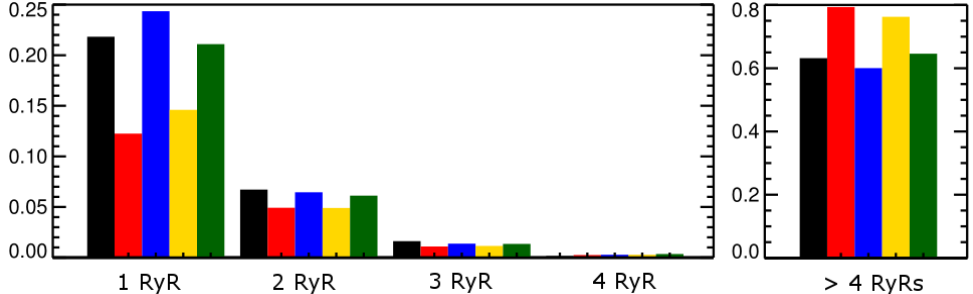
applied, and the lower red line shows the nadir of average [Ca 2+ ]SR level at the corresponding beat.